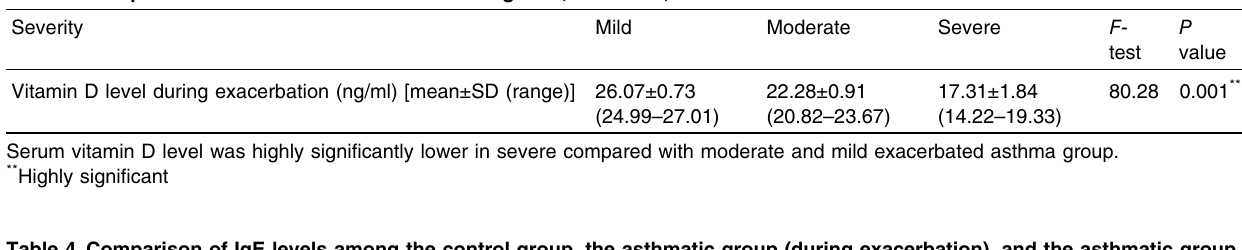
Table 4 Comparison of IgE levels among the control group, the asthmatic group (during exacerbation), and the asthmatic group (after remission) Control group